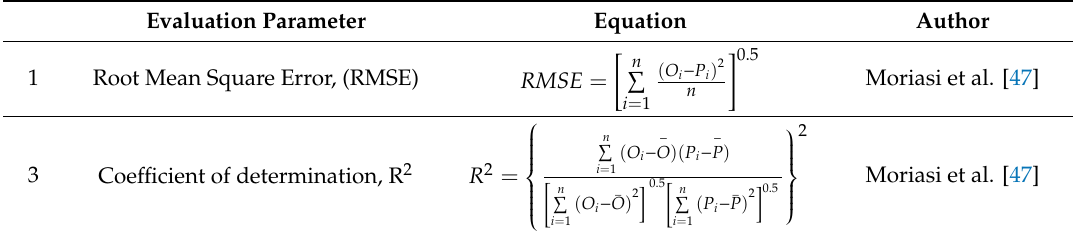
Table A1. List of evaluation parameters used in the manuscript. Evaluation Parameter